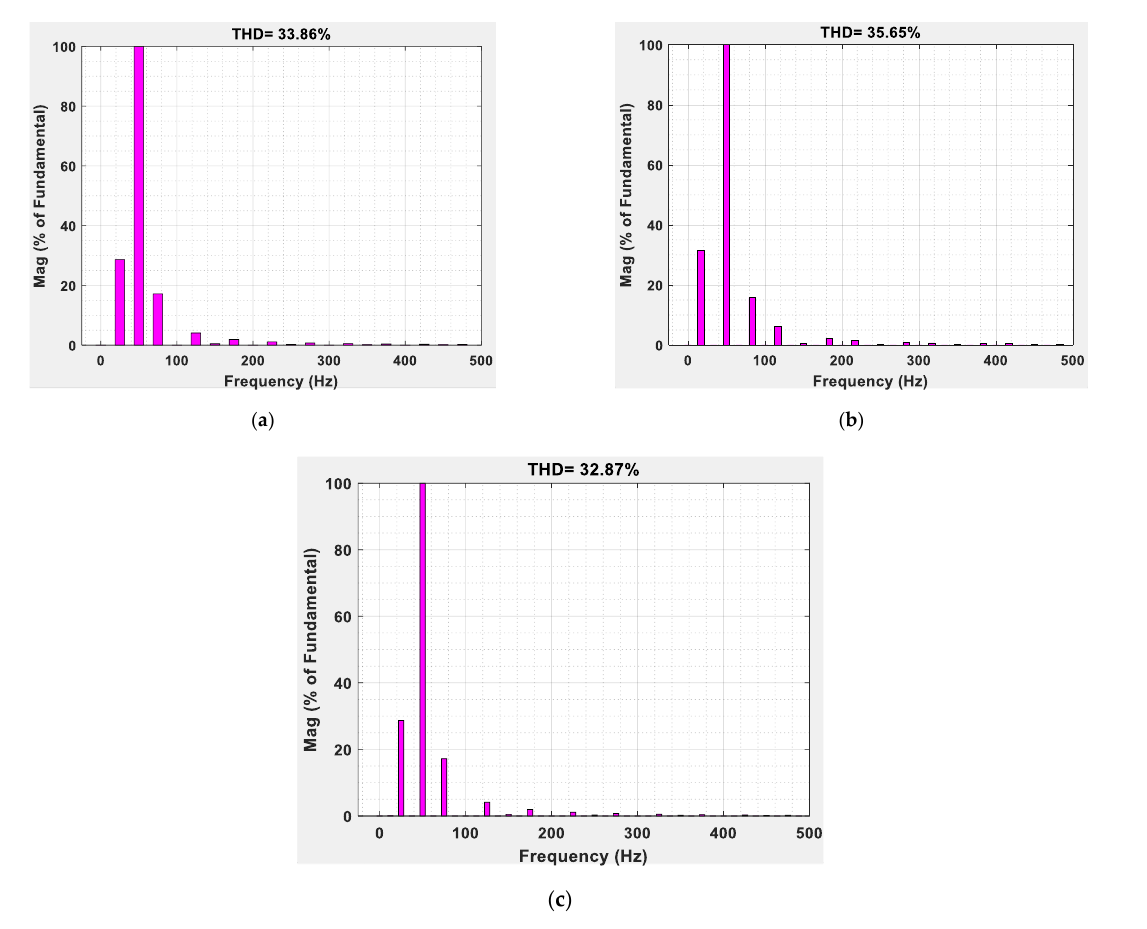
Figure 11. FFT spectrum of the input current with output voltage regulation capabilities for output frequency requirement: ( a ) one-half; ( b ) one-third; and ( c ) one-fourth.